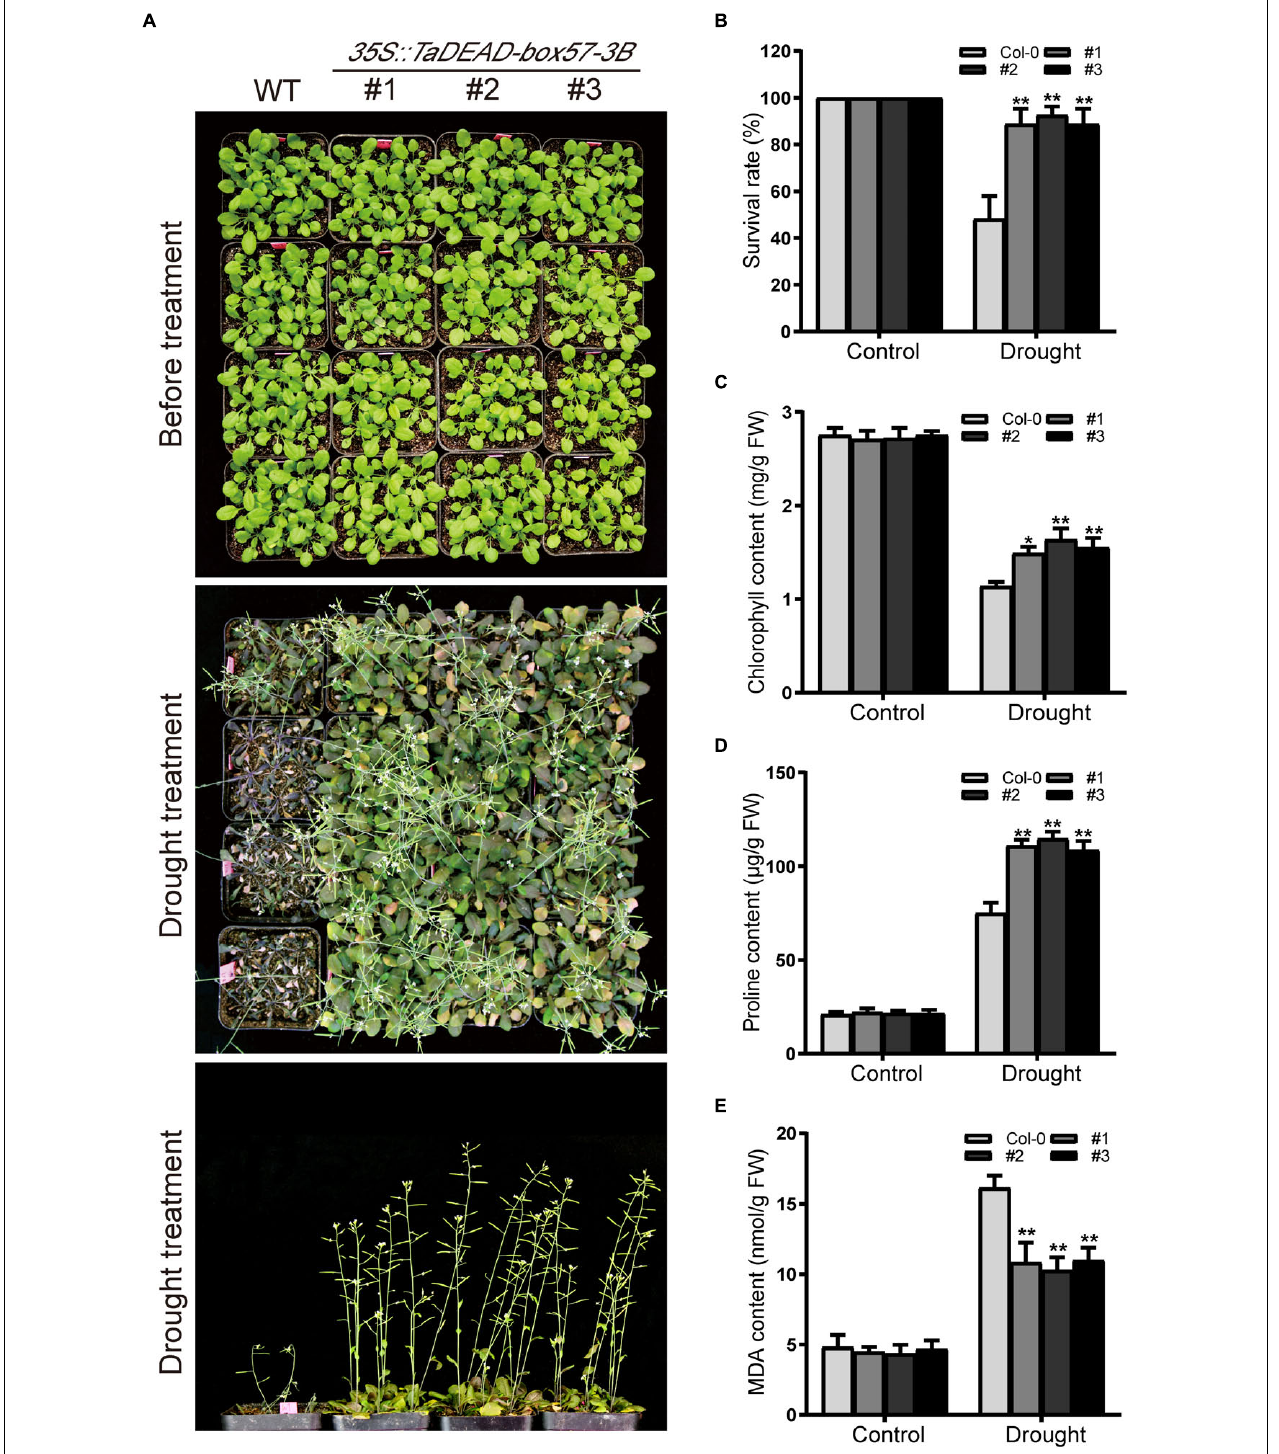
FIGURE 10 | Ectopic expression of TaDEAD-box57-3B enhanced drought tolerance in transgenic Arabidopsis . (A) Phenotypes of 21-day-old WT and TaDEAD-box57-3B transgenic plants under drought stress. (B) The survival rates of WT and transgenic plants under drought condition was monitored 7 days after rewatering. (C-E) The physiological indicators of WT and transgenic plants under normal and stress treatments, including chlorophyll (C) , proline (D) , and MDA (E) contents. All the data represent the means ± SDs of three independent biological replicates and asterisks (*or **) represent the significant differences at p < 0.05 or p < 0.01(ANOVA